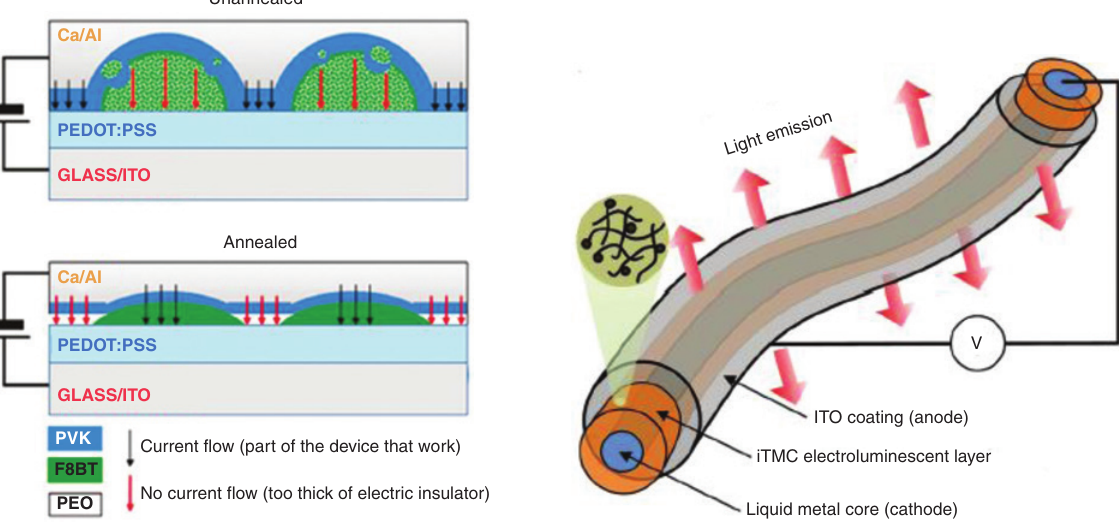
Figure 9: Schematic showing the effect of annealing on blended PEO/F8BT. Results reveal a change in the current path through device layers. (Reprinted with permission from Vohra et al. ACS Nano, 5, 5572. © 2011 American Chemical Society).